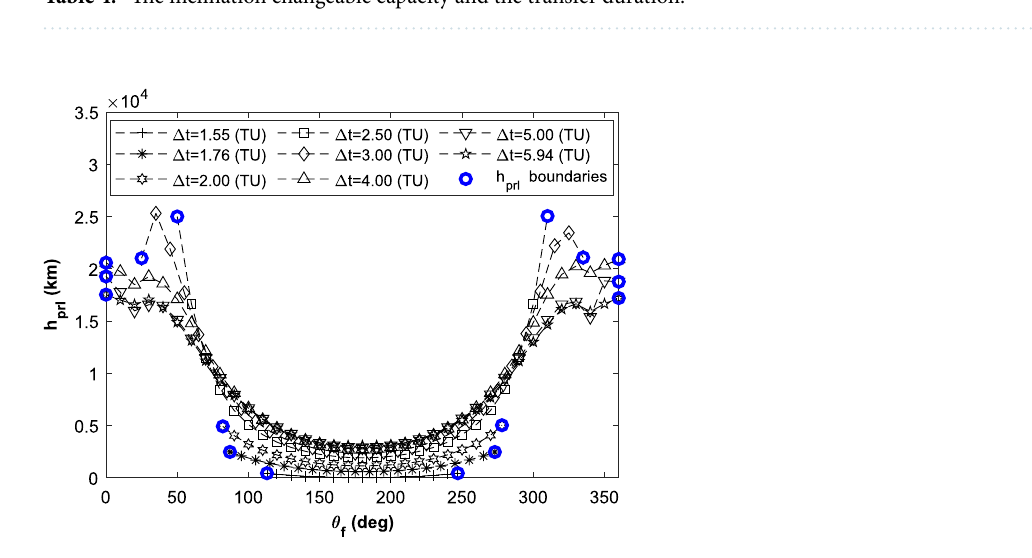
Figure 15. Perilune altitude changes in the spatial